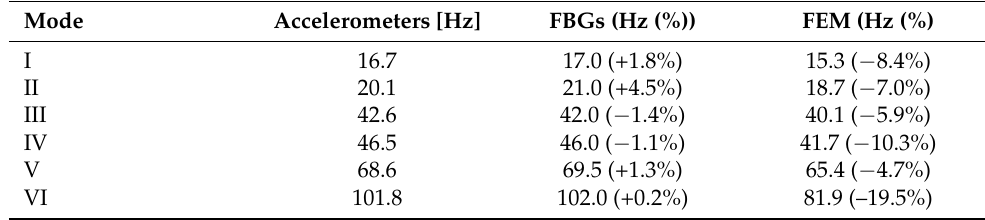
Figure 8. SFRF stabilization diagram of FBG data.